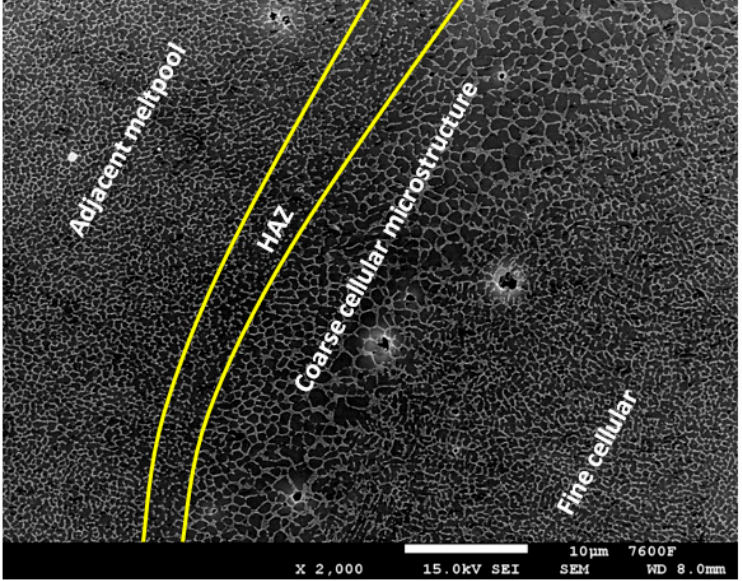
Figure 3. SEM image of an as-built sample of L-PBF AlSi10Mg alloy in transverse cross-section, showing microstructure at the melt pool boundaries. At a smaller scale (Figure 4), a typical fine microstructure of the supersaturated solid solution of the α -Al phase and Si continuous network can be observed.